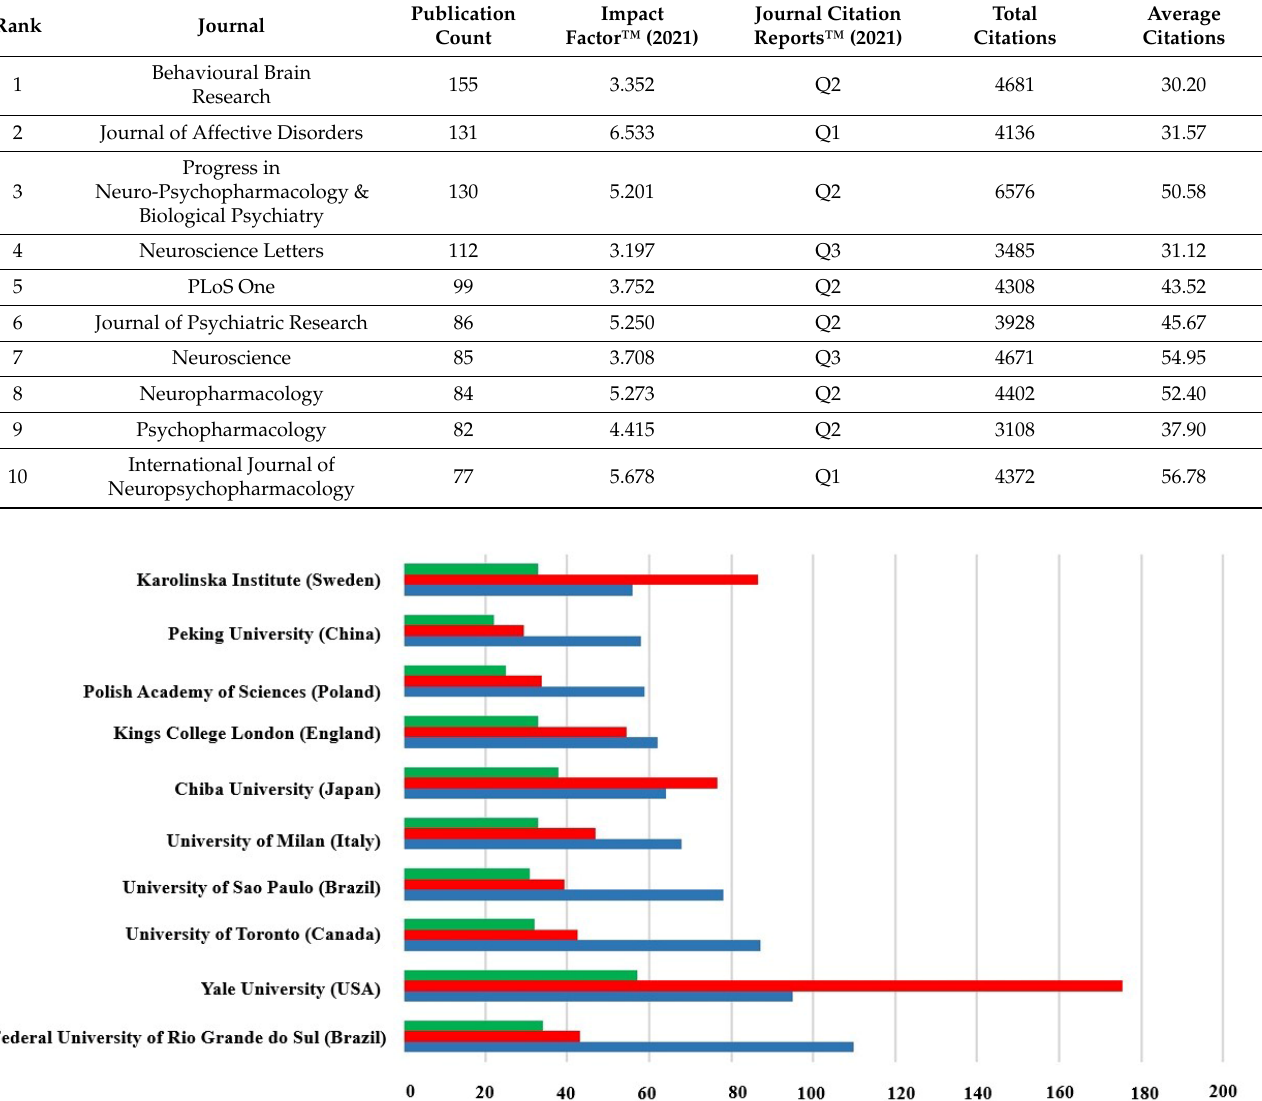
Table 3. Journal analysis. The top 10 journals for the association between depression and BDNF research.